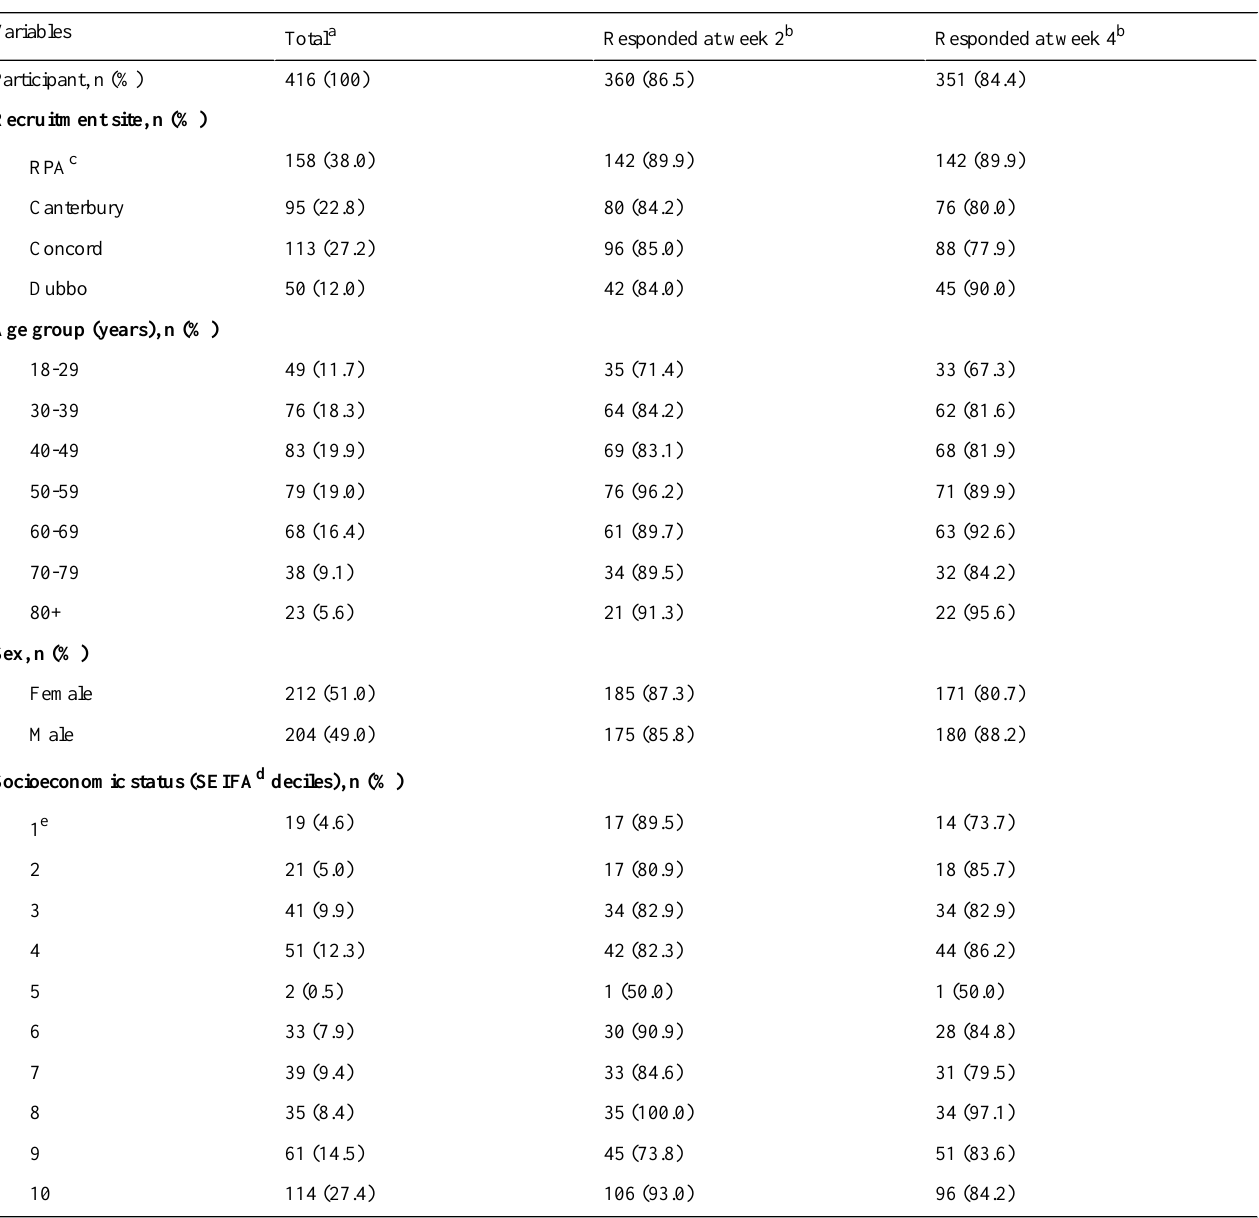
Table 2. Participants’characteristics and response rates at weeks 2 and 4, grouped by recruitment site, age, sex, and socioeconomic status